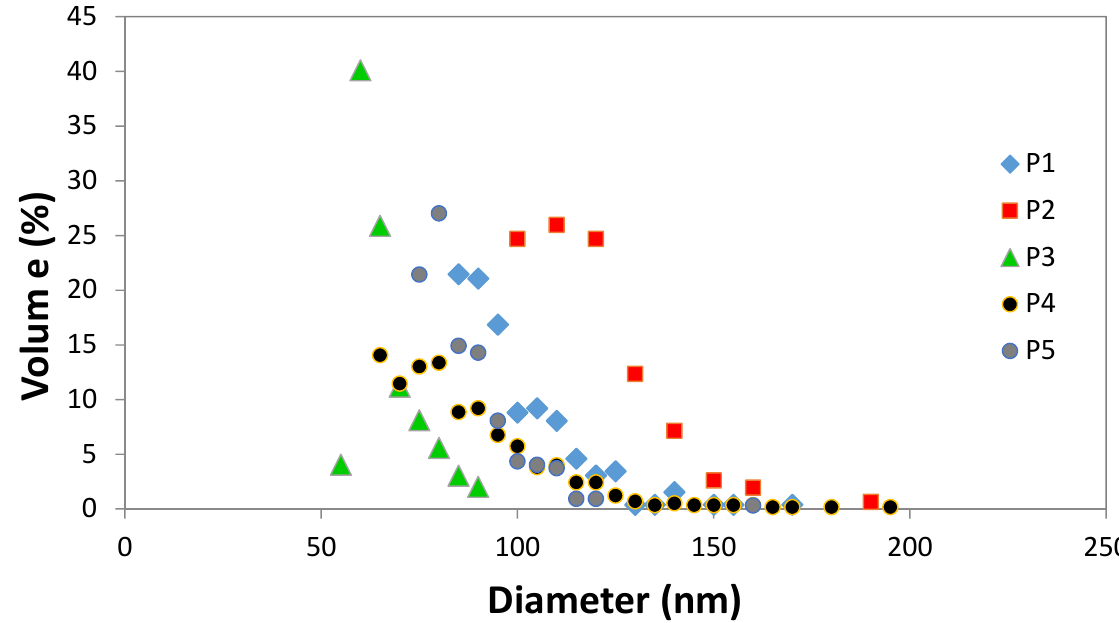
Figure 4. Pore size distribution of the top surface of PPSU-PES membranes.